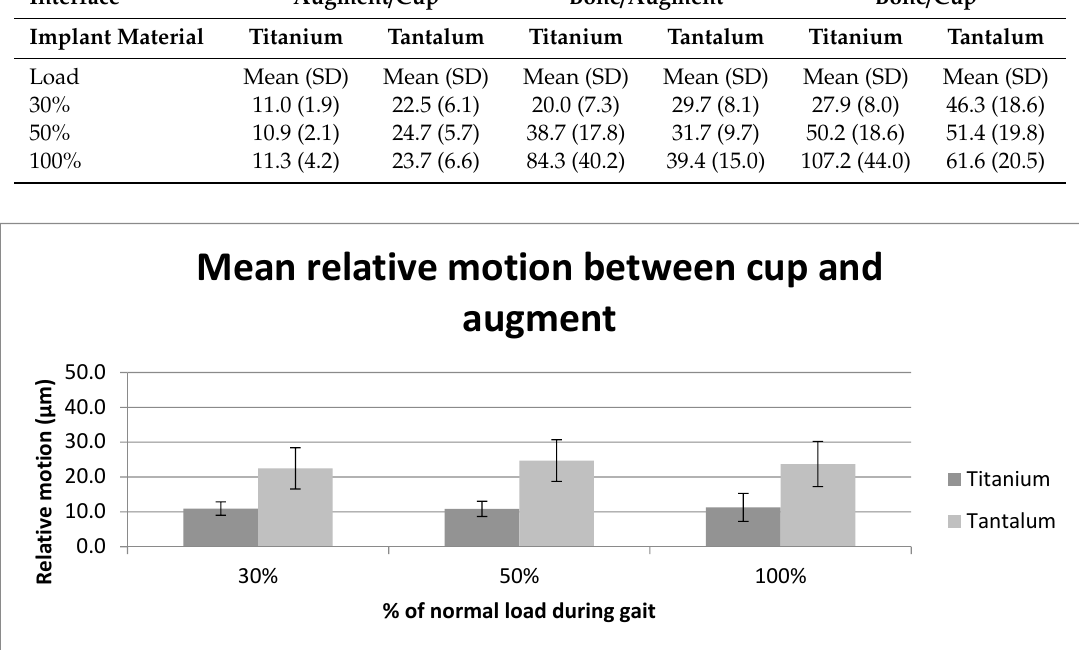
0.010.0 0.010.0